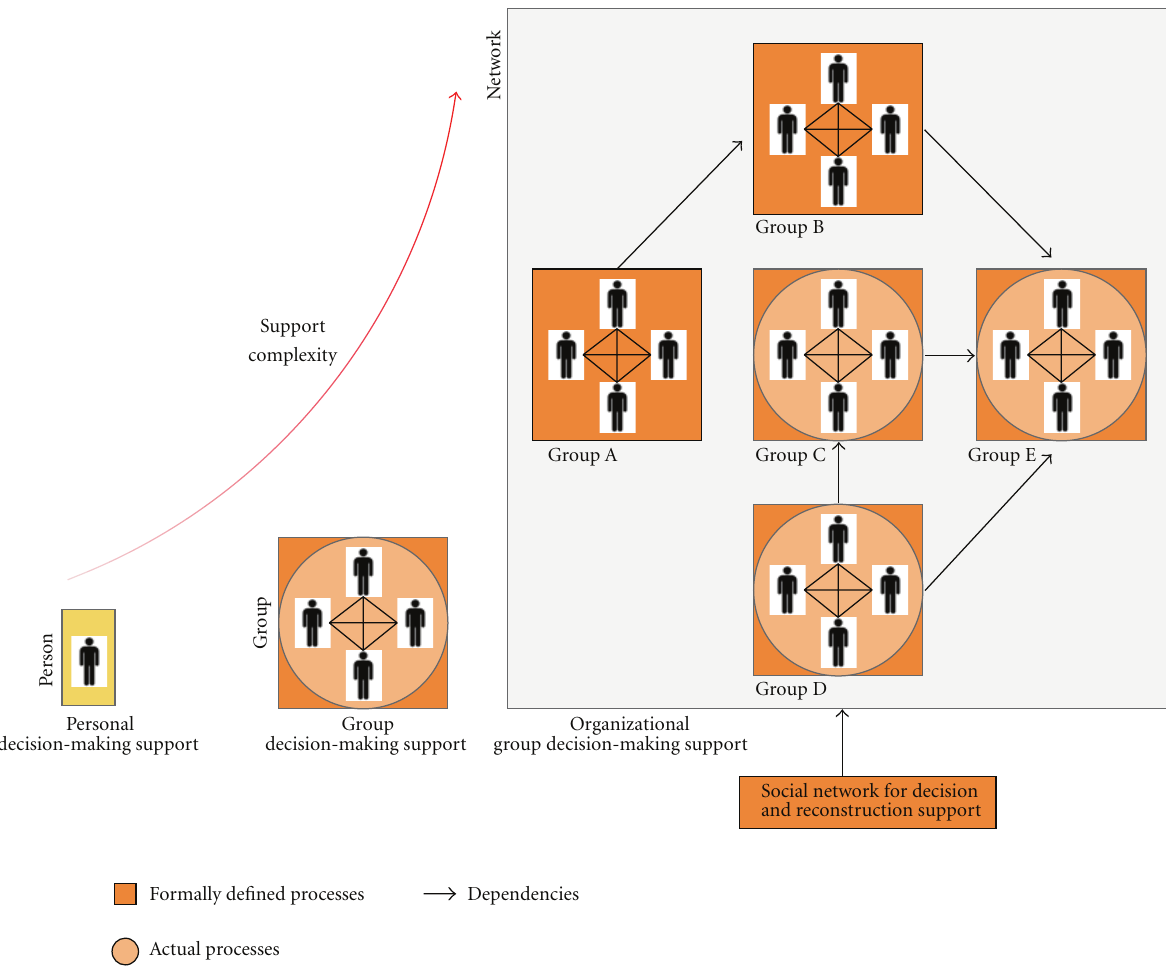
Figure 1: Using the social network model for organizational group decision-making